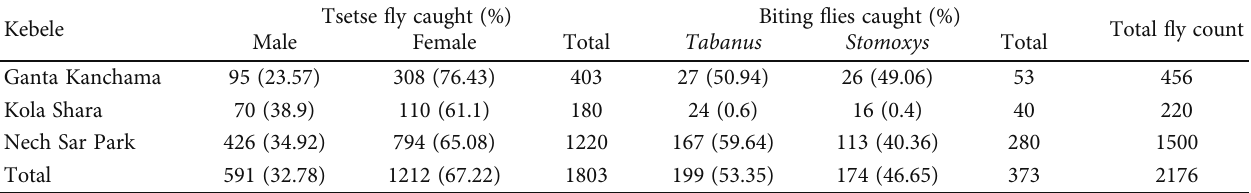
Table 1: Proportions of each fl y count in the study area.